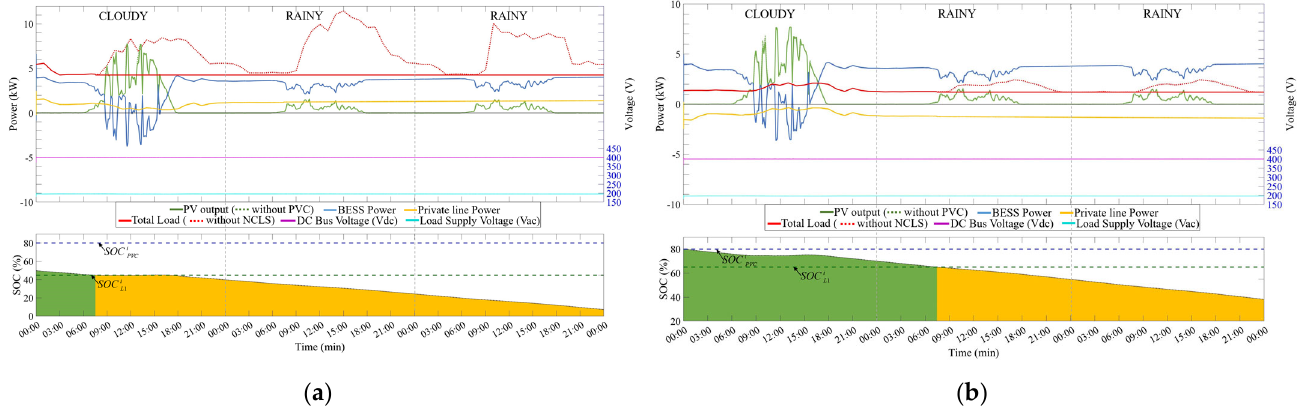
( b ) Figure 14. Test case 5 (Connected). ( a ) Performance of prosumer X. ( b ) Performance of prosumer Y.